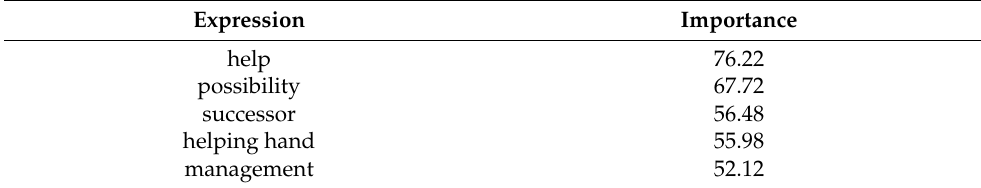
Table 6. Weight of criteria: intergenerational